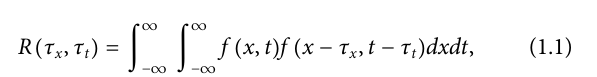
autocorrelation function. R ( τ x , τ t ) will get a relatively large value when ( τ x , τ t ) is along the direction of the stripes on the space-time image. Fourier transform is usually used in the actual calculation and R is normalized. The large R value area will be gathered to the